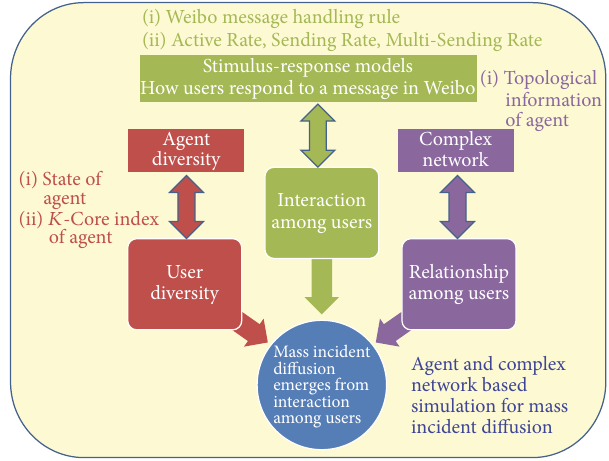
Figure 1: Agent and complex network based simulation for mass incident